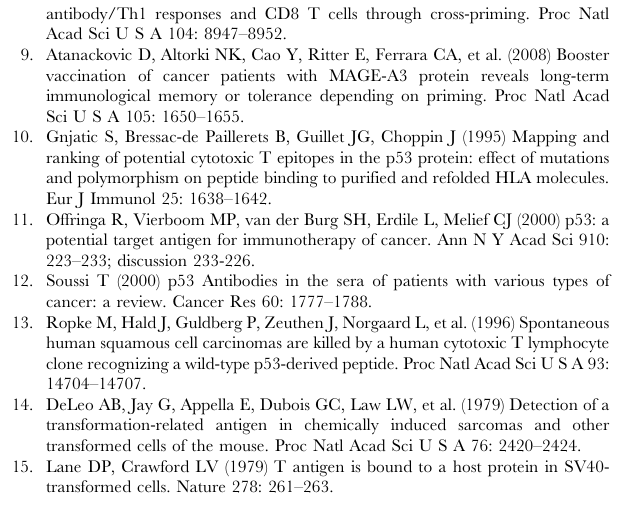
Figure S1 Spontaneous T cell responses against NY-ESO-1 in seropositive ovarian cancer patients and healthy donors. CD8 + (A) and CD4 + (B) T cells from NY-ESO-1 seropositive ovarian cancer patients and healthy individuals in the same study cohort of p53 immunomonitoring were presensitized with NY-ESO-1 overlap- ping peptides and NY-ESO-1-specific T cells were evaluated by ELISPOT assays using the same protocol used to monitor T cell responses against p53. Figure S2 Detection of p53-specific CD4 + T cells by intracel- lular cytokine staining. CD4 + T cells from p53 seropositive and seronegative ovarian cancer patients were presensitized with p53 overlapping peptides and p53-specific T cells were evaluated by intracellular cytokine staining of TNF- a and IL-4. (A) Represen- tative staining after co-culture with p53-peptides subpool-pulsed or unpulsed target cells. (B) Summary of cytokine expressing cells in 4 seropositive and 4 seronegative patients. Table S1 Numbering of overlapping peptides for wild-type p53. Table S2 Spontaneous immune responses against tumor-related antigens investigated in the New York Branch of Ludwig Institute for Cancer